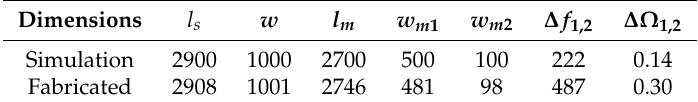
Figure 1. Schematic image of the M-shape harvester design. Table 2 outlines the dimensions of the design. Table 2. Characteristic features for simulated and fabricated M-shape